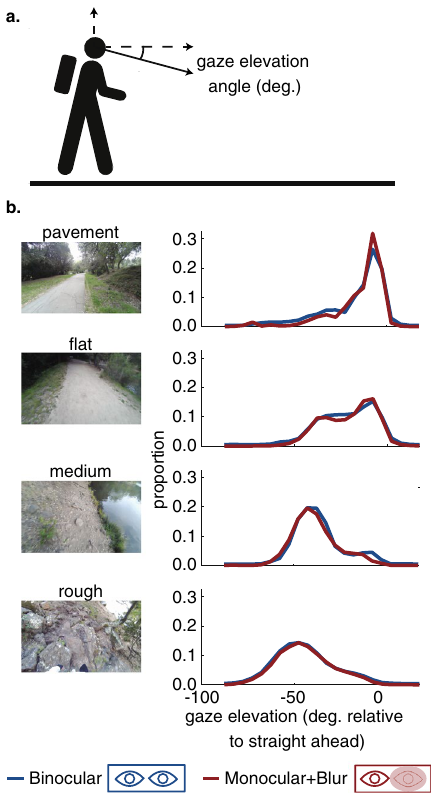
Figure 2. Analysis of gaze distributions do not show consistent differences in gaze distributions across the binocular and blur conditions. ( a ) Schematic showing how the gaze elevation angle is measured (where the vertical axis is defined by gravity). ( b ) Distribution of gaze angles relative to the horizontal for the different ◦ ◦ terrain types. Gaze angles between − 40 and − 50 are roughly 2–3 footholds ahead. The blue line shows data for normal binocular vision and red shows the distributions in the stereo-impaired condition where one eye was blurred using a a 0.2 Bangerter foil. Data are pooled across 8 participants with stereoacuity in the normal